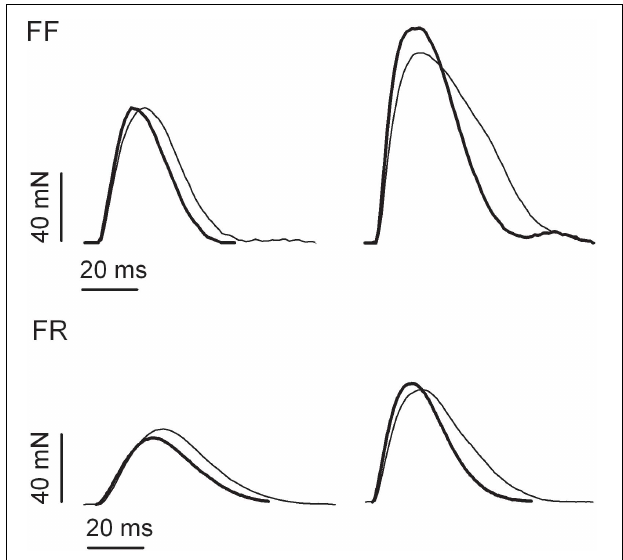
FIGURE 1 | Examples of isometric twitch responses of fast fatigable (FF) and fast fatigue resistant (FR) motor units of medial gastrocnemius muscle obtained from untrained (thin lines) and resistance-trained animals (thick